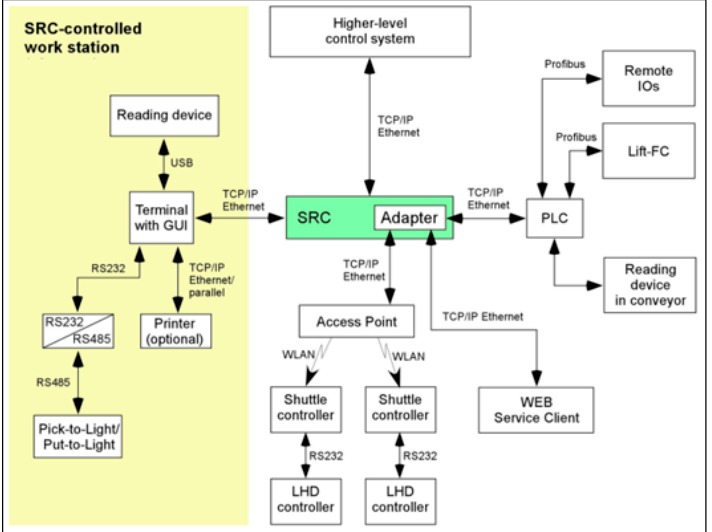
Figure 8. Shuttle interface diagram.